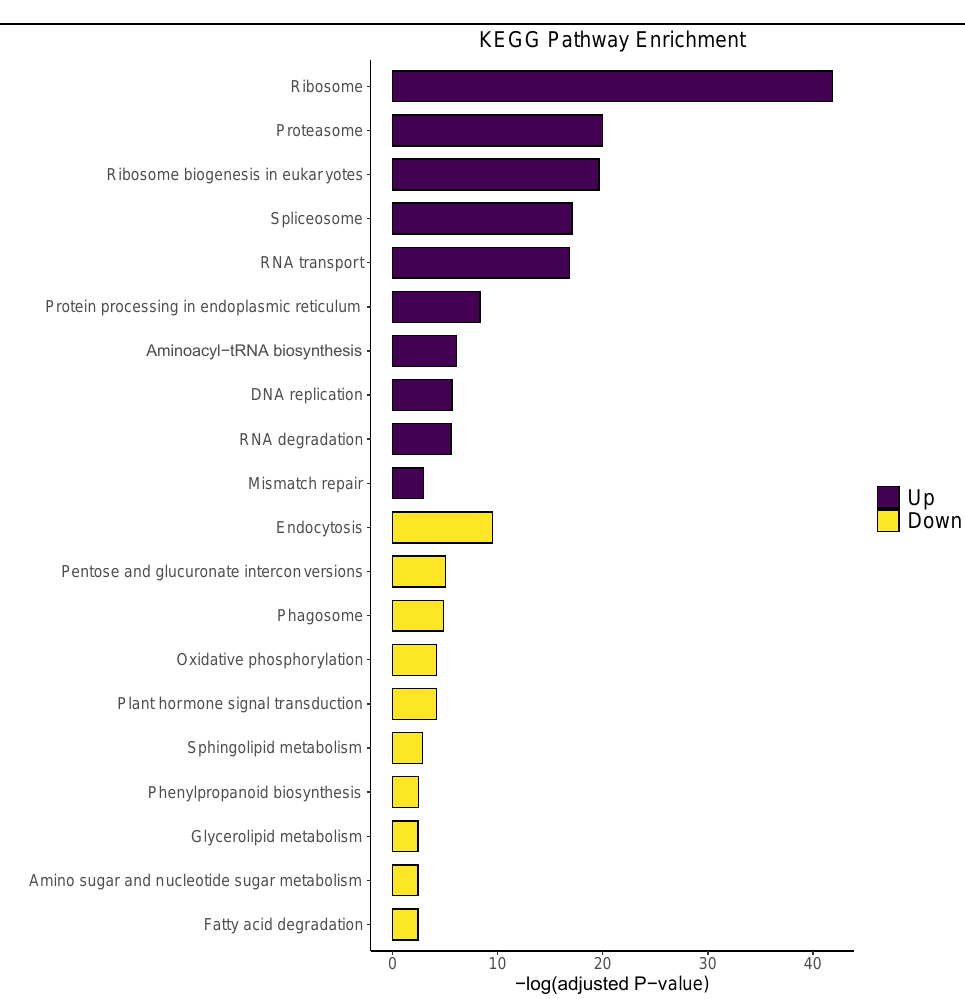
Figure 3. Kyoto Encyclopedia of Genes and Genomes (KEGG) pathway enrichment of differentially expressed genes (DEGs). Up- (purple) and downregulated (yellow) cellular pathways in temperature- stressed microspores with respect to the control population. A comprehensive list of enriched KEGG pathways is available in Supplementary File 3.